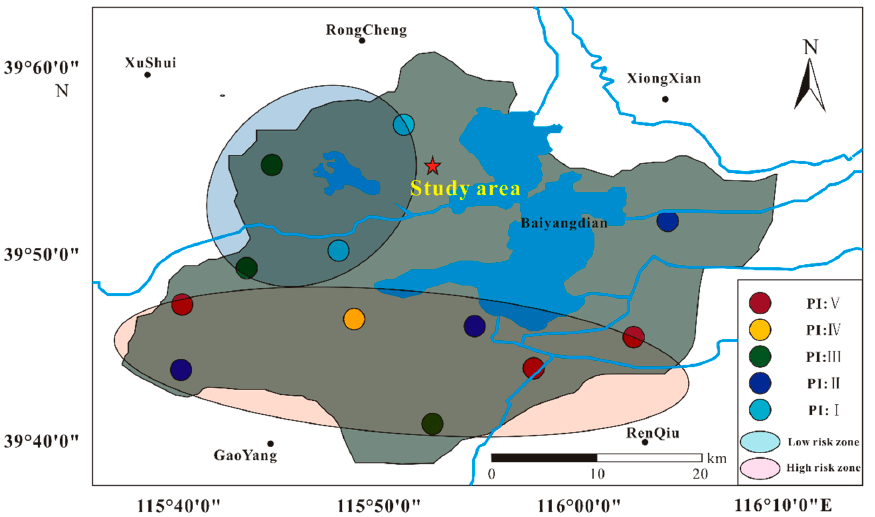
Figure 5. Risk degree of MPs in the study area. Different colors represent different polymer risk indexes.